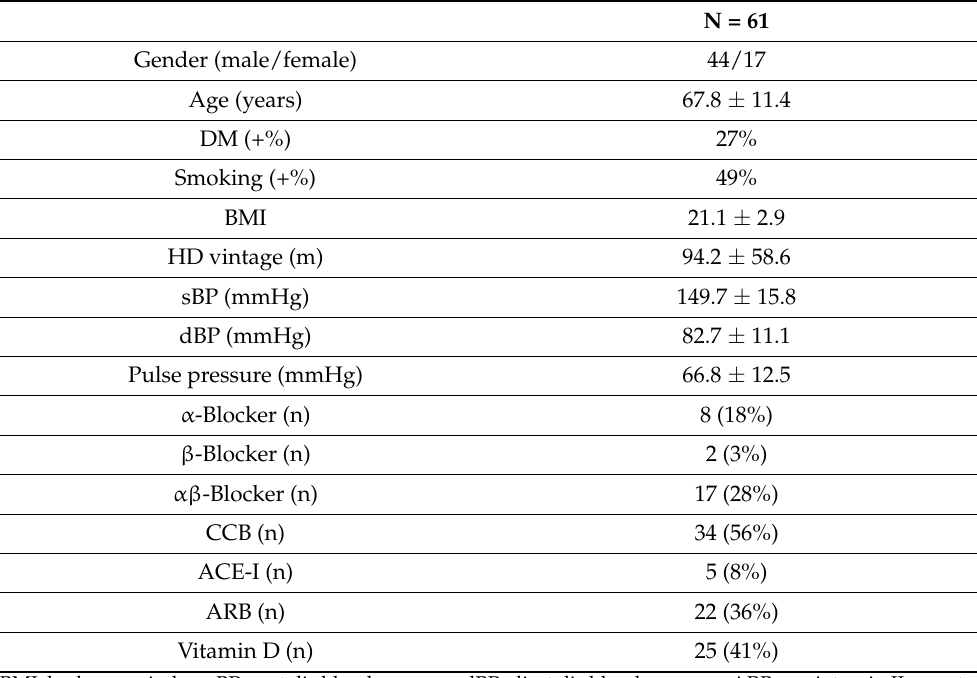
Table 1. Baseline patient characteristics.